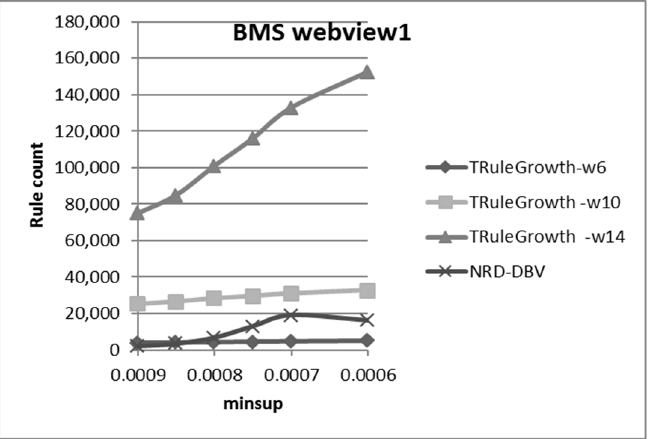
Figure 4. Comparison of the runtime of the TRuleGrowth with the NRD-DBV for (BMS webview1) dataset.